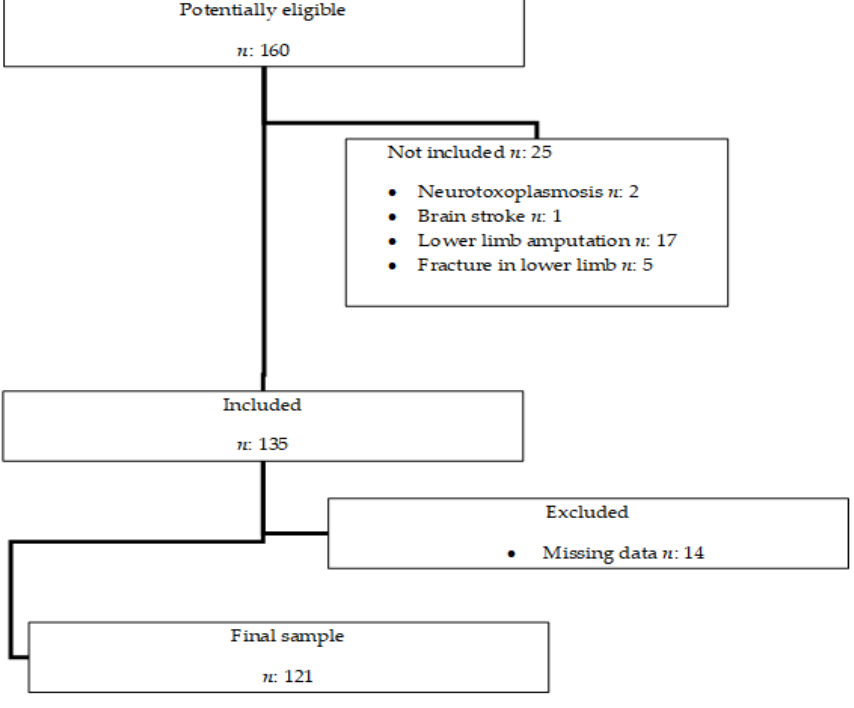
Figure 1. Study sample selection flowchart.